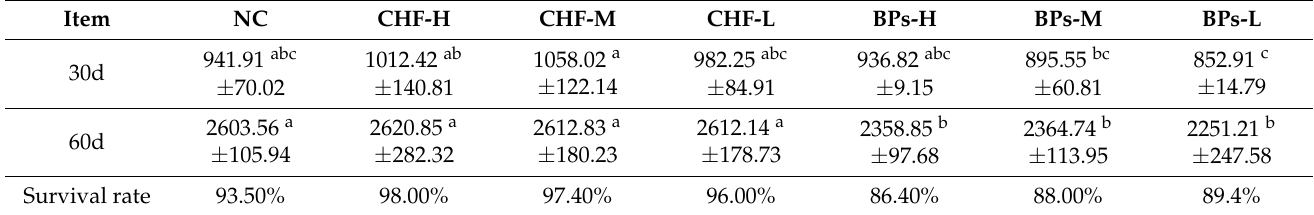
Table 4. Comparison of live weight and survival rate at 30 and 60 days